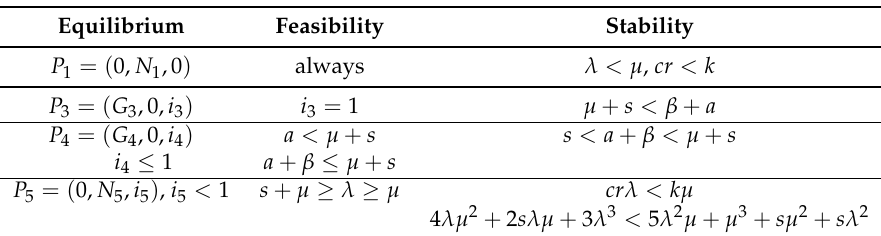
Table 2. Summary of the feasibility and stability conditions for the equilibria with at least one vanishing